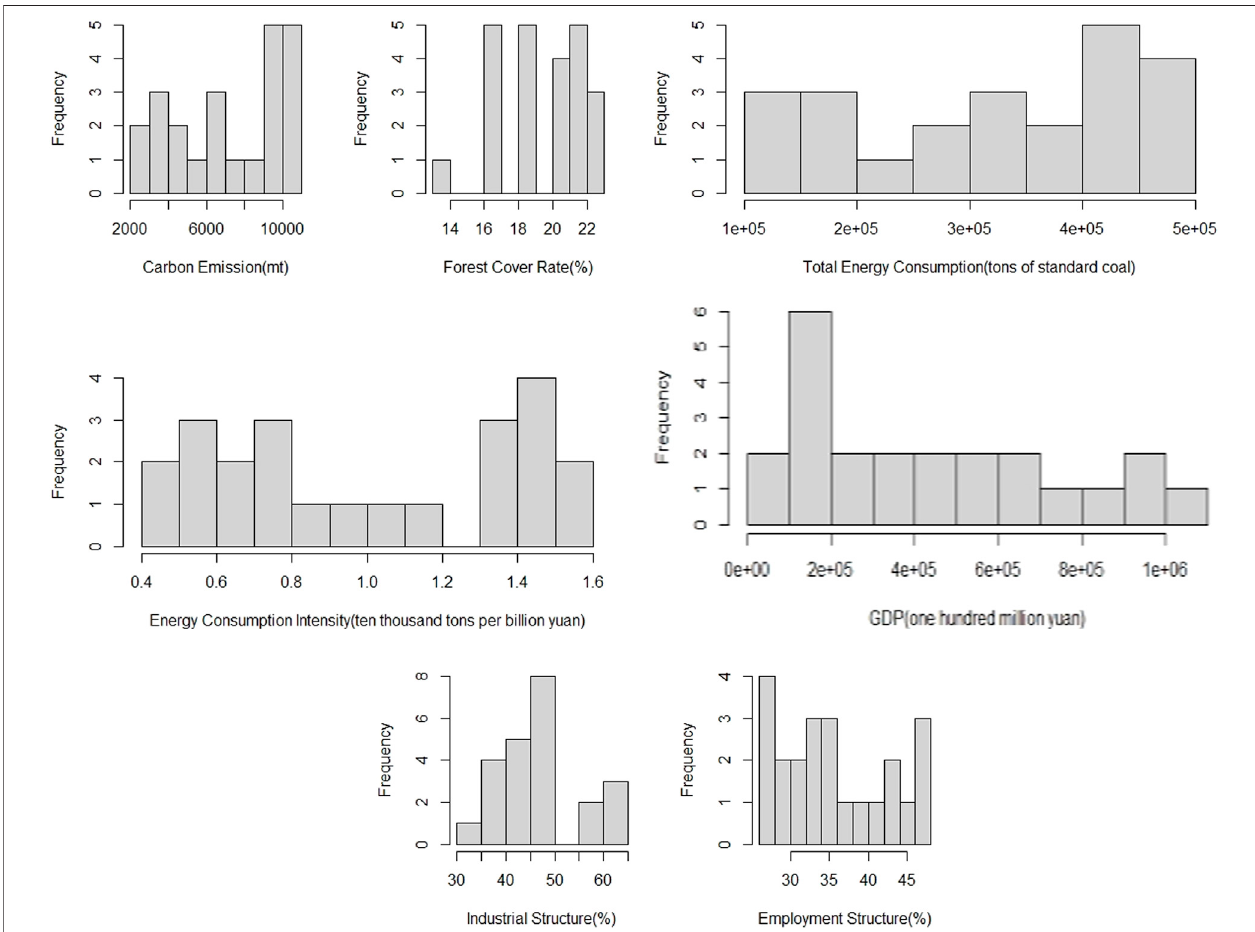
FIGURE 1 | The histogram of carbon emission and six covariates distributions skewed to the left, and the last four being positive and skewed to the right. The kurtosis for these data is − 1.605, − 1.130, − 1.487, − 1.705, − 1.255, − 0.712, and − 1.285, all negative, meaning the distributions are fl atter than the normal distribution. The data histograms in Figure 1 and the model presented in this study do not appear to contradict each other, indicating that the model is plausible.